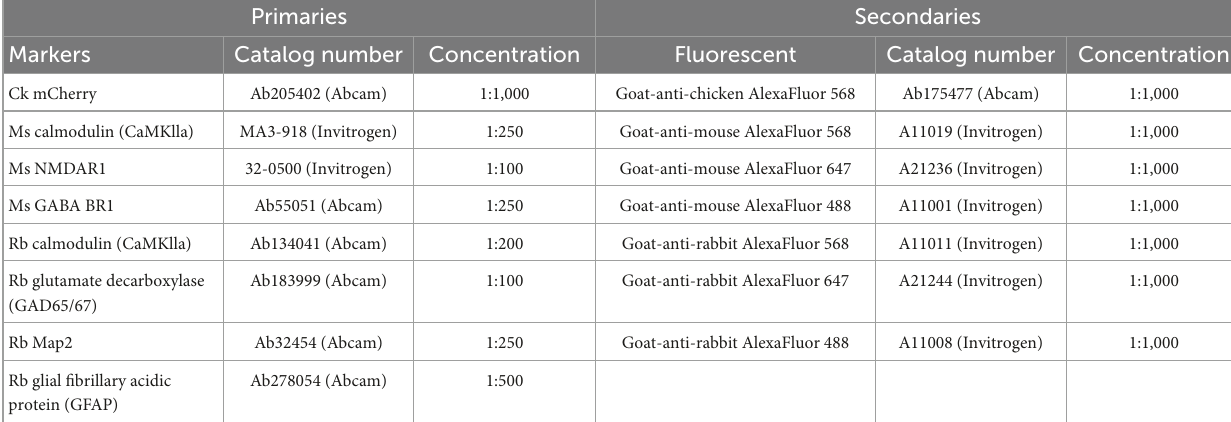
TABLE 1 Overview of primary and secondary antibodies, species, and